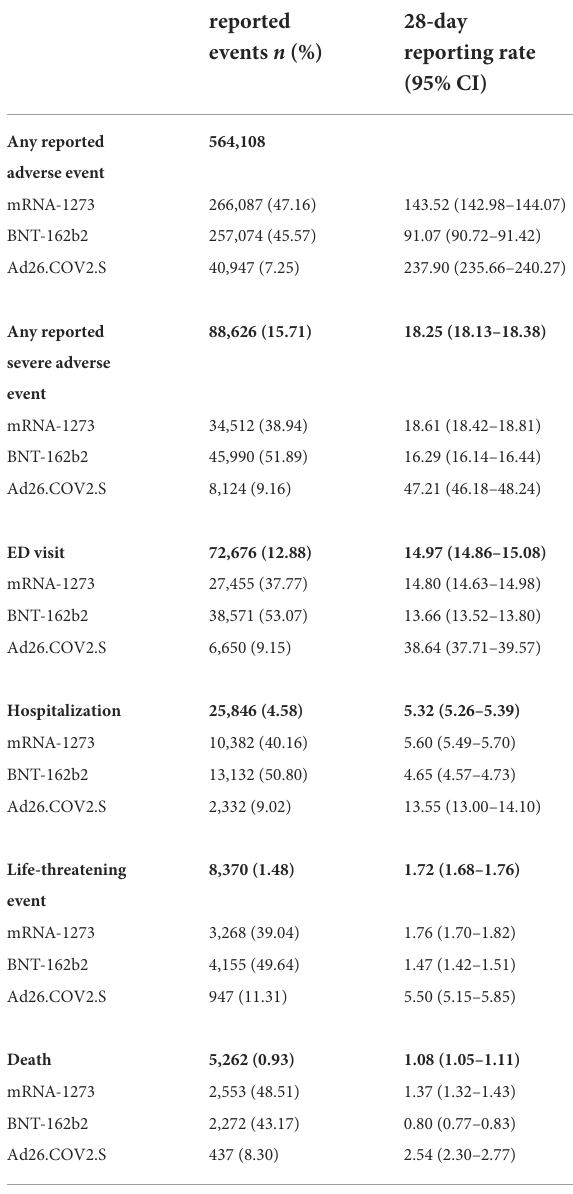
TABLE 2 Crude cumulative reporting rates for severe adverse